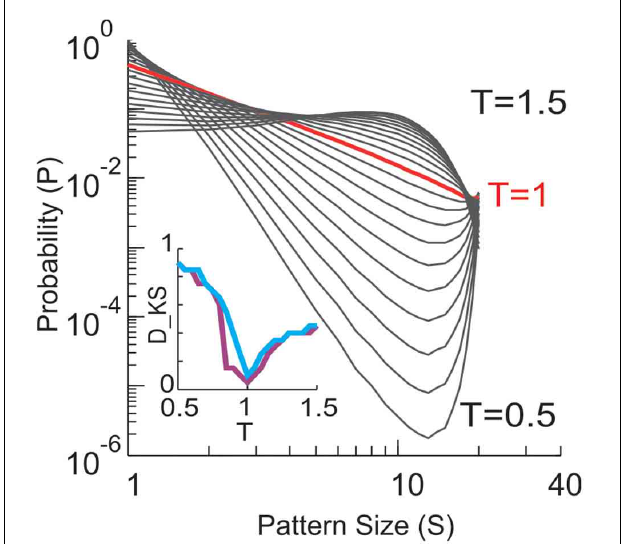
FIGURE 13 | Size distributions of avalanche patterns computed for one 20-electrode sub-group (taken from data set in Figure 1D) for different T and plotted in double logarithmic coordinates. T changes from 0.5 to 1.5 with a step of 0.05. Distribution at T = 1 is marked by red. Inset: Kolmogorov–Smirnov distance ( D KS , a goodness-of-fit measure) between the actual pattern size distributions and best fitting power law (purple) or power law with slope − 1.5 (blue) is minimized for T ≈